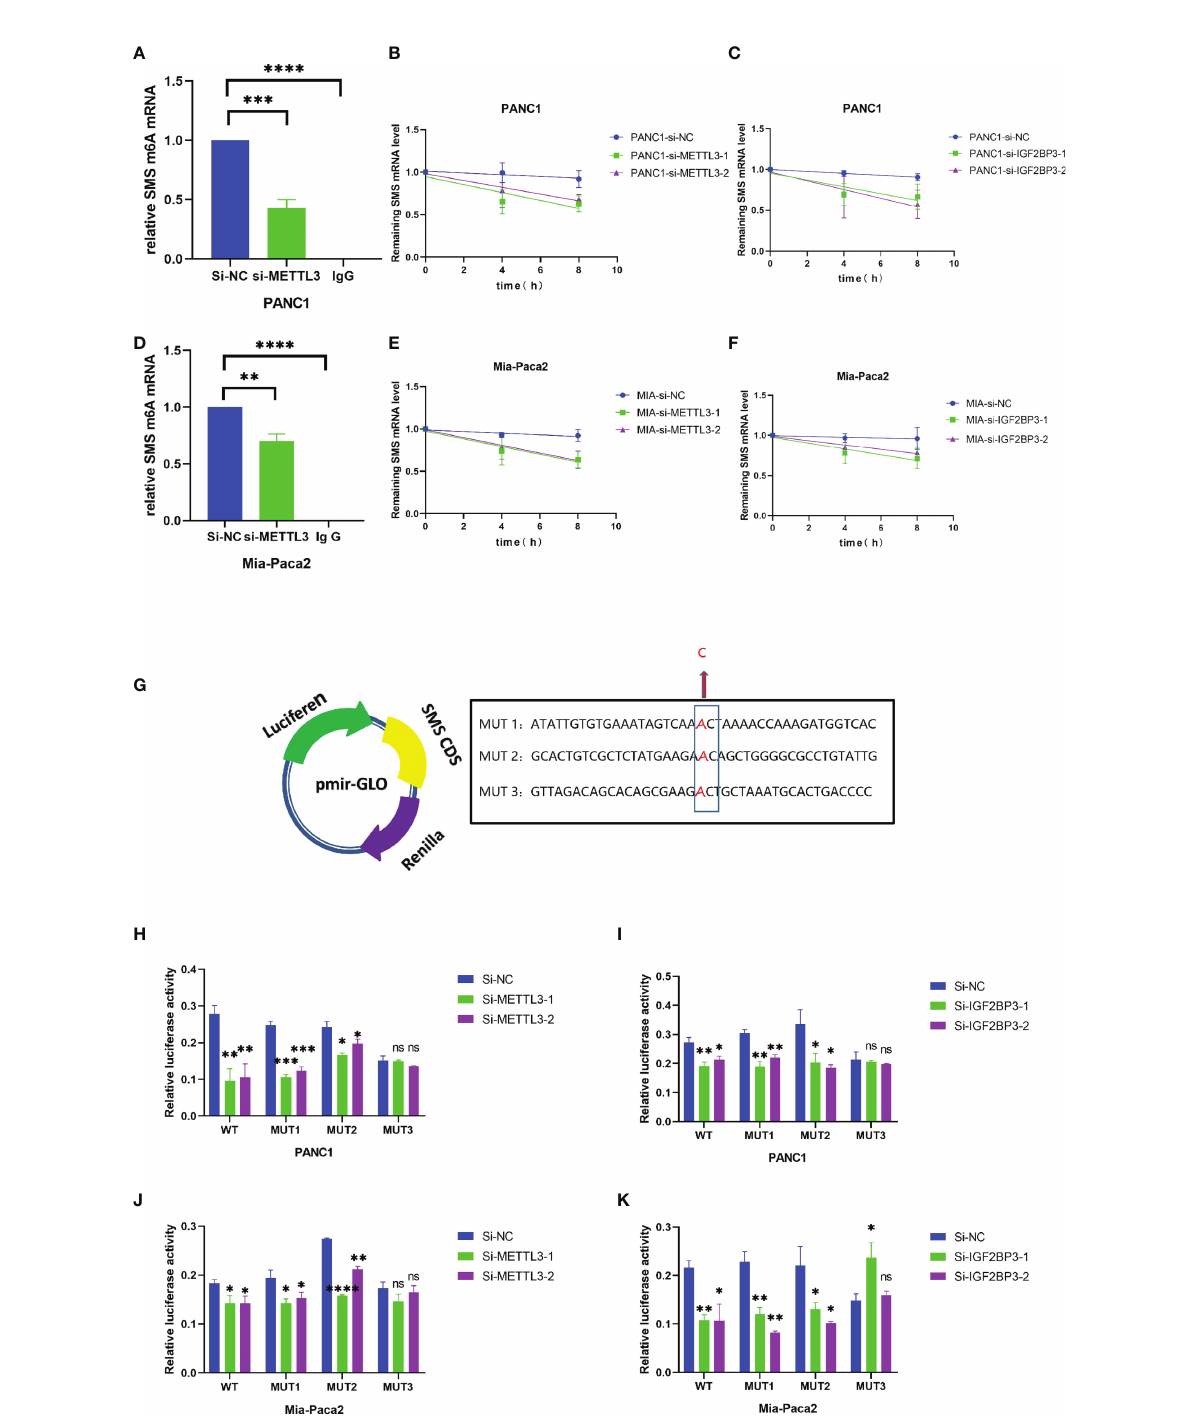
FIGURE 6 The METTL3-IGF2BP3 axis promotes increased SMS mRNA stability and protein expression by mediating SMS m6A modi fi cation. (A, D) ME-RIP assays showed the relative percentage of SMS mRNA with methylation. (B, C, E and F) The mRNA stability and degradation halftime of SMS in Mia-Paca2 and PANC1 treated by Actinomycin D. (G) Wild-type or mutant 1-3 sites m6A consensus sequence was fused with fi re fl y luciferase reporter, respectively. (H-K) Mutation of m6A sites in SMS (constructed in fi re fl y reporter) repressed the luciferase expression of reporter. *P < 0.05; **P < 0.01; ***P < 0.001; ****P < 0.0001. ns, no signi fi